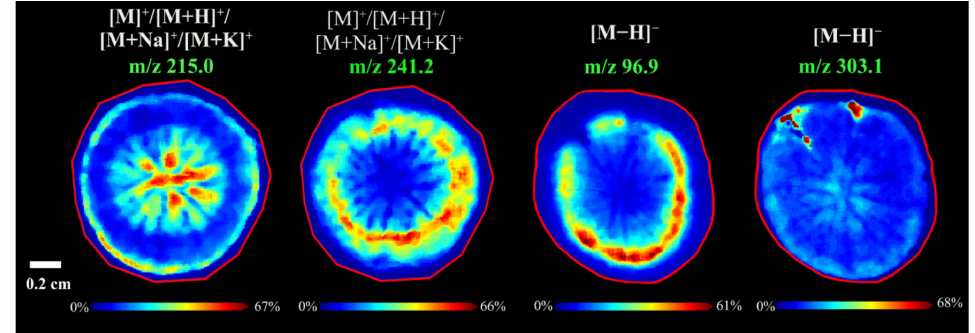
Figure 6. MALDI MS images of unidentified components in A. lappa